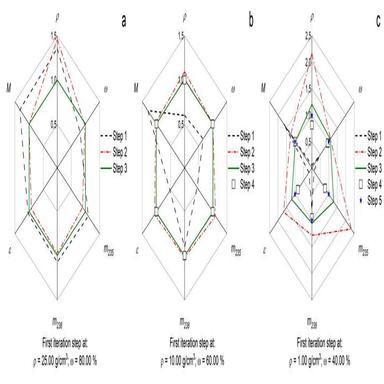
Visualization of iterative algorithm operation for the metal uranium.